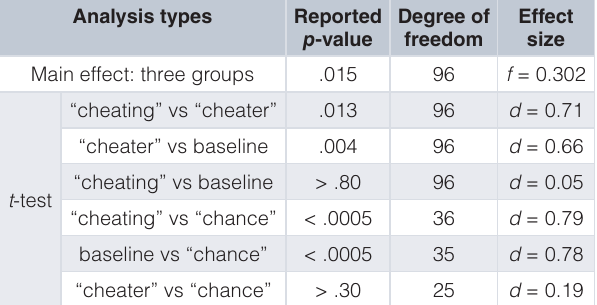
Table 1. Results of Experiment 3 of Bryan et al.